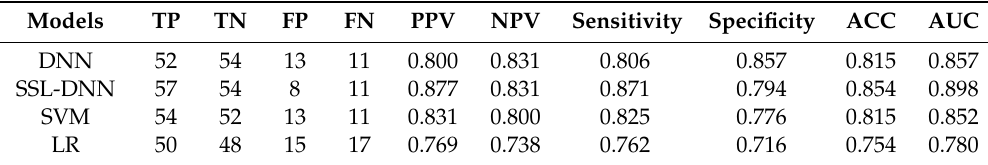
Table 4. Performances of the supervised and semi-supervised learning models.